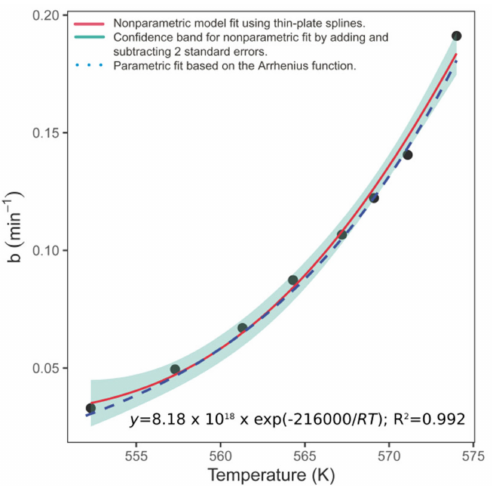
Figure 5. Fittings obtained with the exponential and the non-parametric